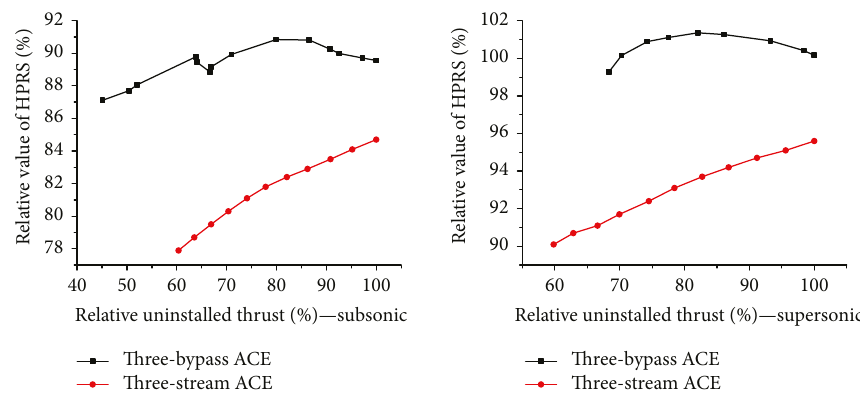
Figure 19: Variation of HPRS during